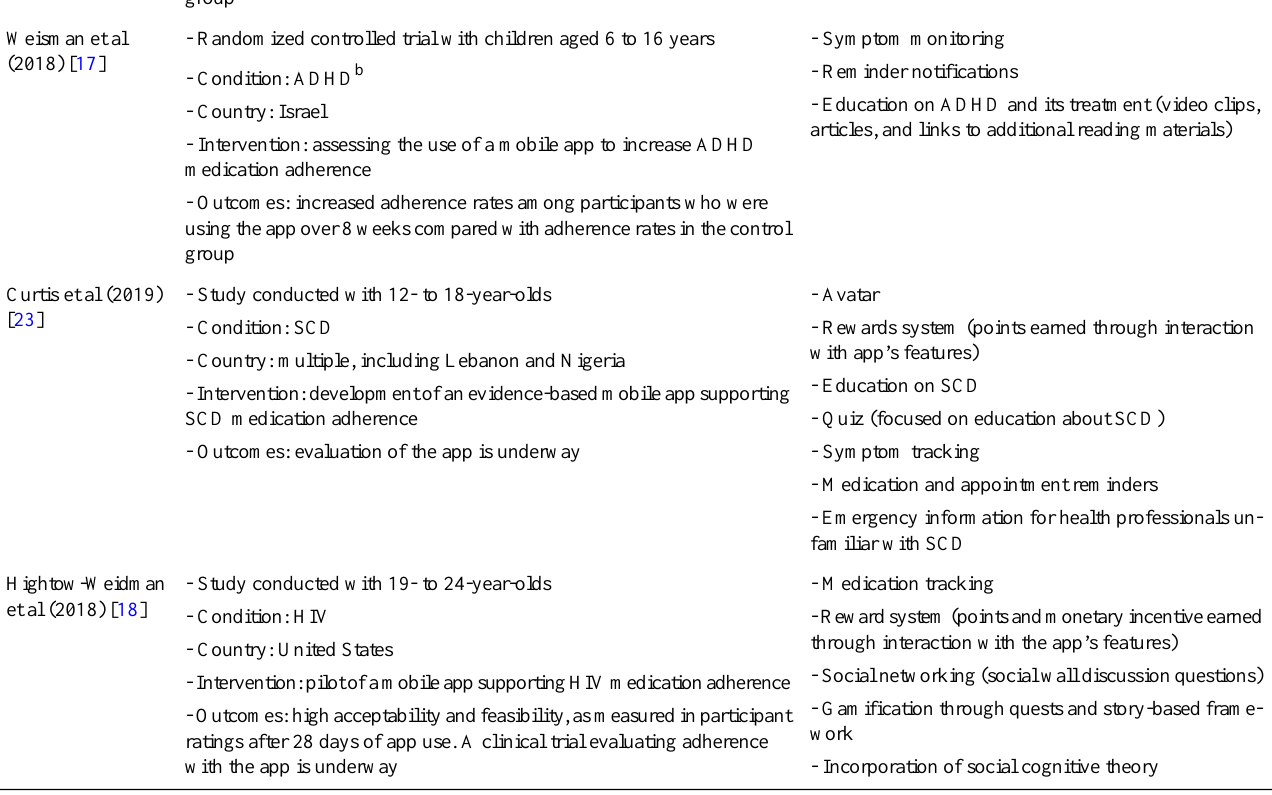
Intervention featuresStudy